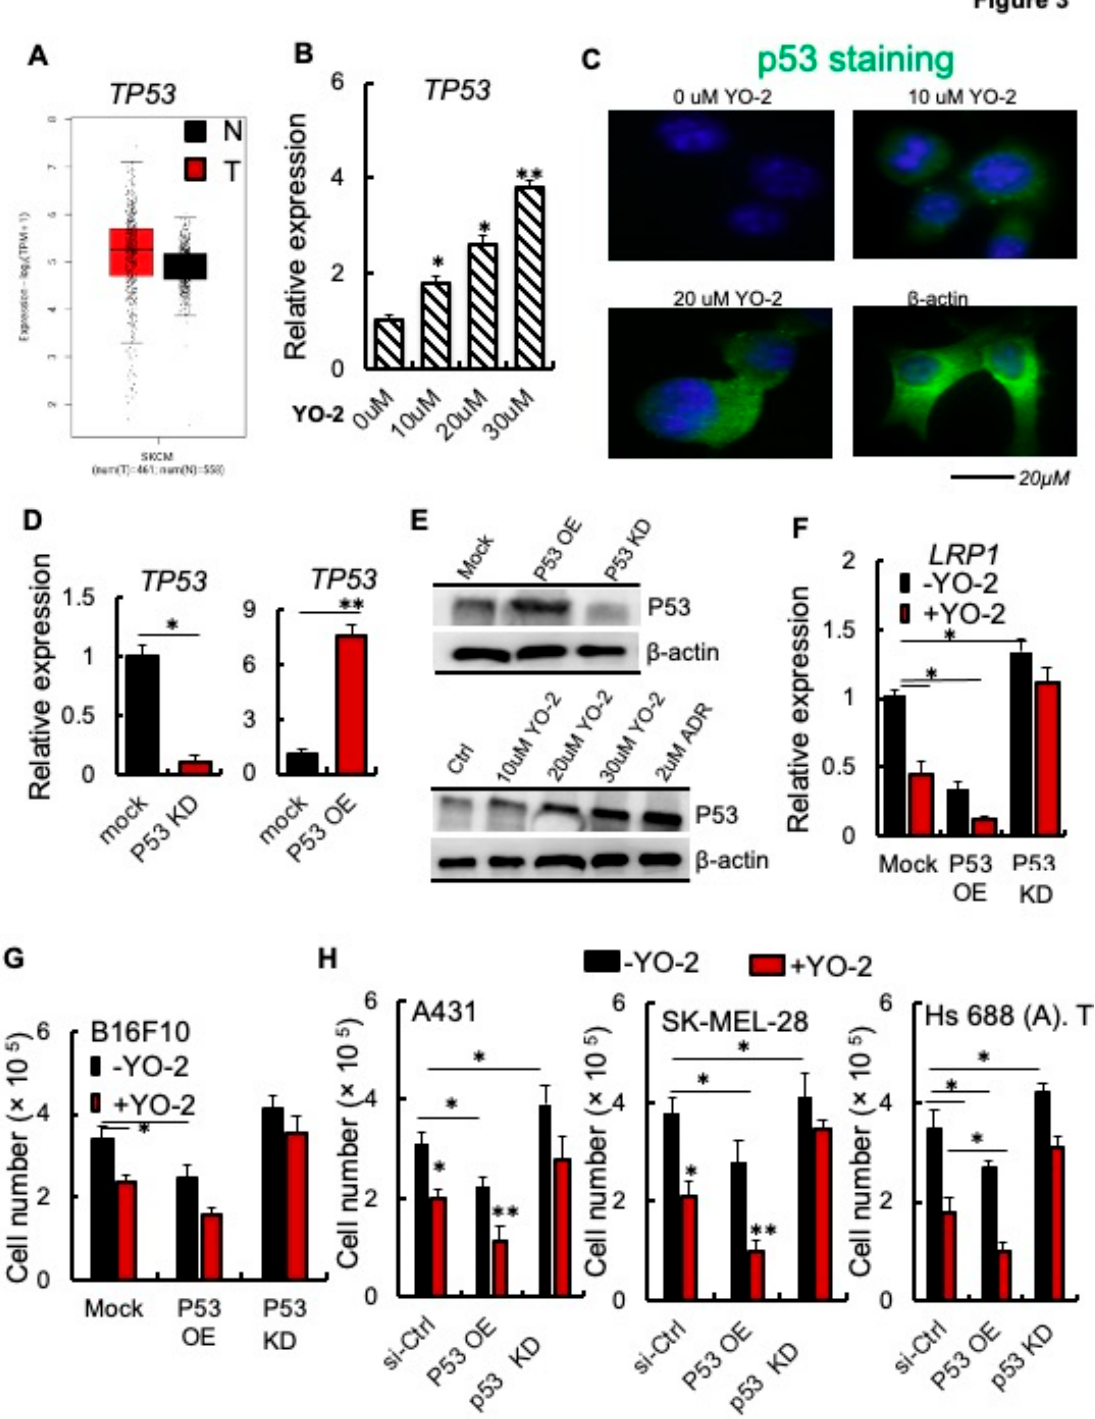
Figure 3. p53 is required for the antiproliferative effects of YO-2 in melanoma cells . ( A ) Human TP53 expression levels in tumor (T) and adjacent normal tissues (N) derived from SKCM patients. Data